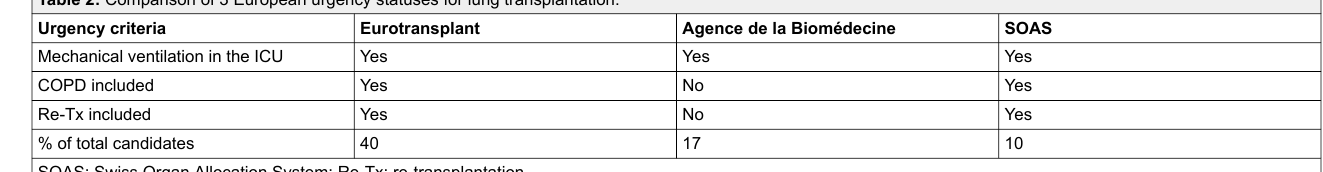
Table 2: Comparison of 3 European urgency statuses for lung transplantation. Urgency criteria Eurotransplant Agence de la Biomédecine